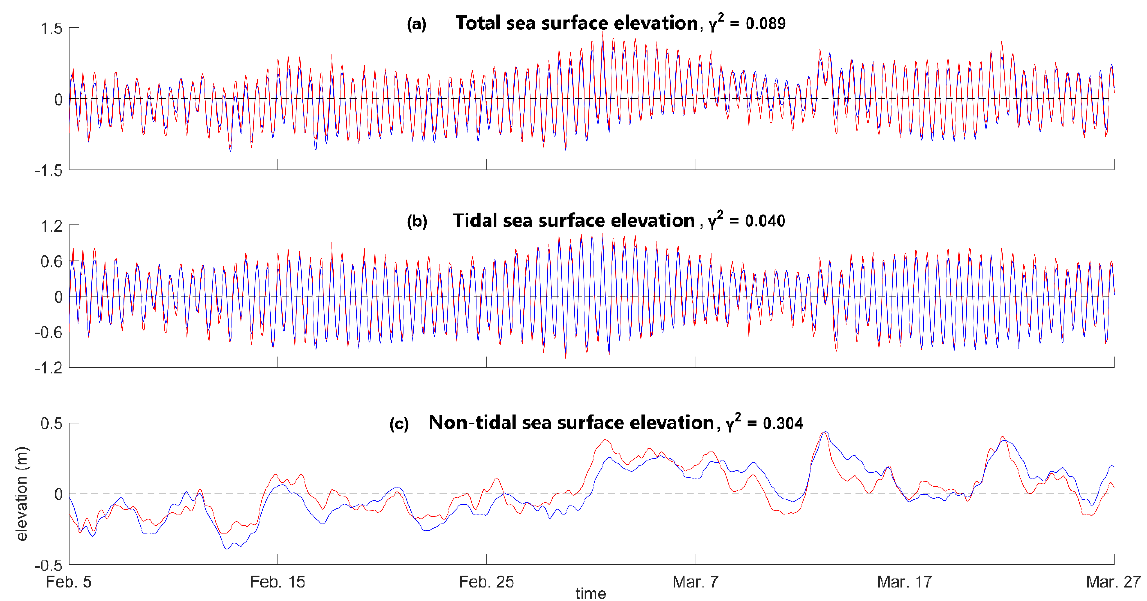
Figure 2. Time series of observed (red) and simulated (blue) ( a ) total, ( b ) tidal, and ( c ) non-tidal sea levels at Halifax for the period from 5 February to 27 March 2018. The simulated results are produced by submodel L1.